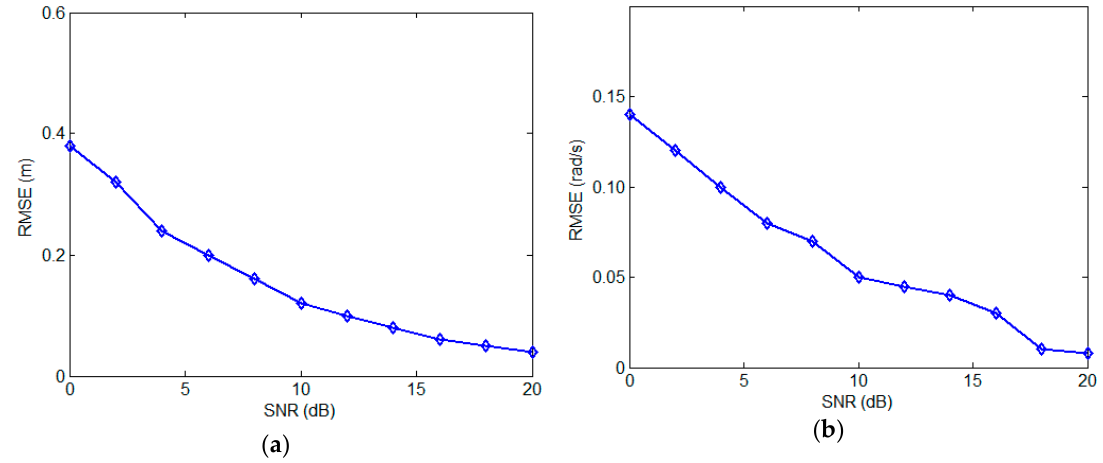
Figure 9. RMSE with respect to SNR. ( a ) 3D geometry; ( b ) spinning angular velocity.